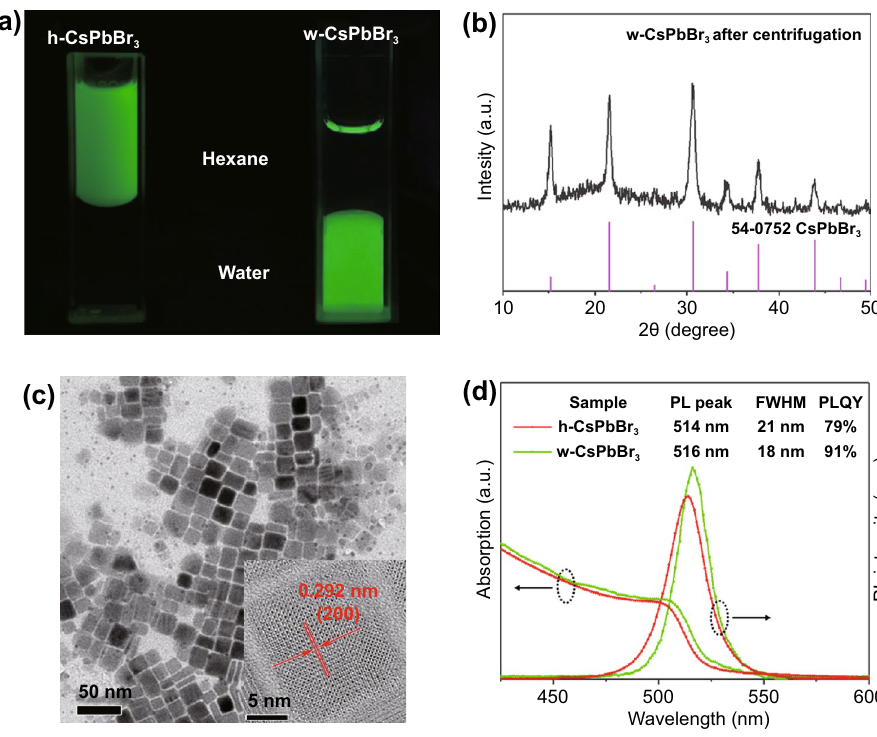
Fig. 2 a Photographs of h‑CsPbBr 3 and w‑CsPbBr 3 NCs under UV light; XRD pattern ( b ) and TEM image ( c ) of w‑CsPbBr 3 NCs after cen‑ trifugation; d UV–vis absorption and PL spectra of w‑CsPbBr 3